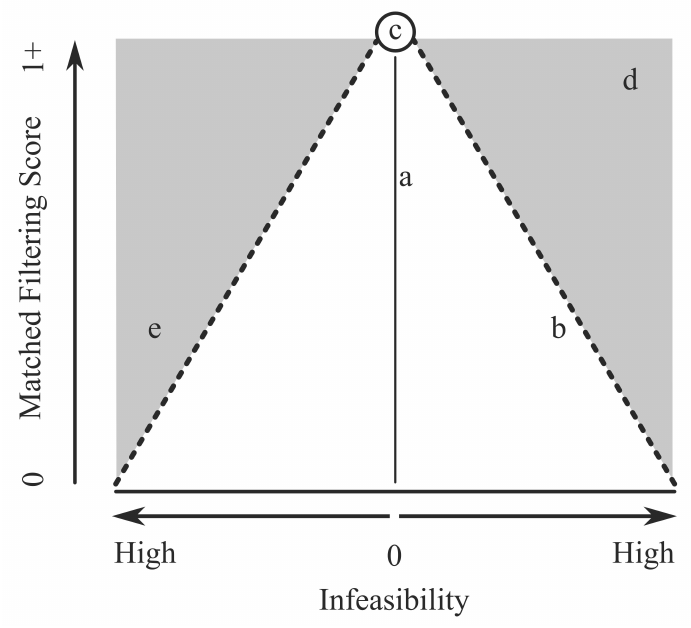
Figure 1. A two-dimensional projection of mixture tuned matched filtering (MTMF) matched filtering (MF) and infeasibility mixture space (after [8]). ( a ) Large MF value and near 0 infeasibility; ( b ) smaller MF value and marginally feasible; ( c ) a perfect MF value and entirely feasible; ( d ) a very large MF value, but very infeasible; ( e ) a small MF value and very